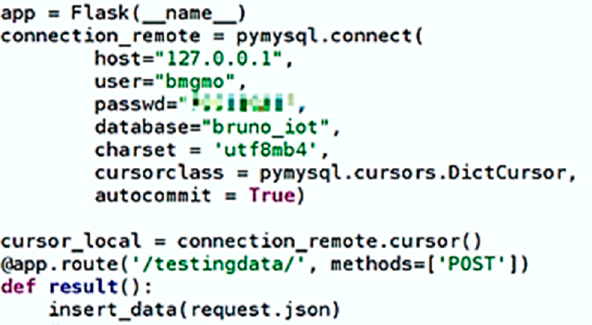
Figure 7. Flash Web Server developed in Python.